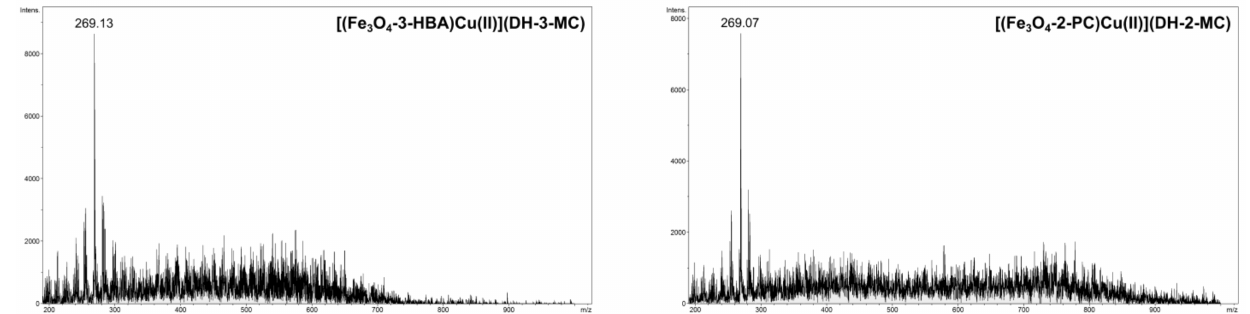
Figure 11. The FAPA-MS spectra of the complexes of chalcones with Cu(II)-complexed Schiff base-functionalized materials.